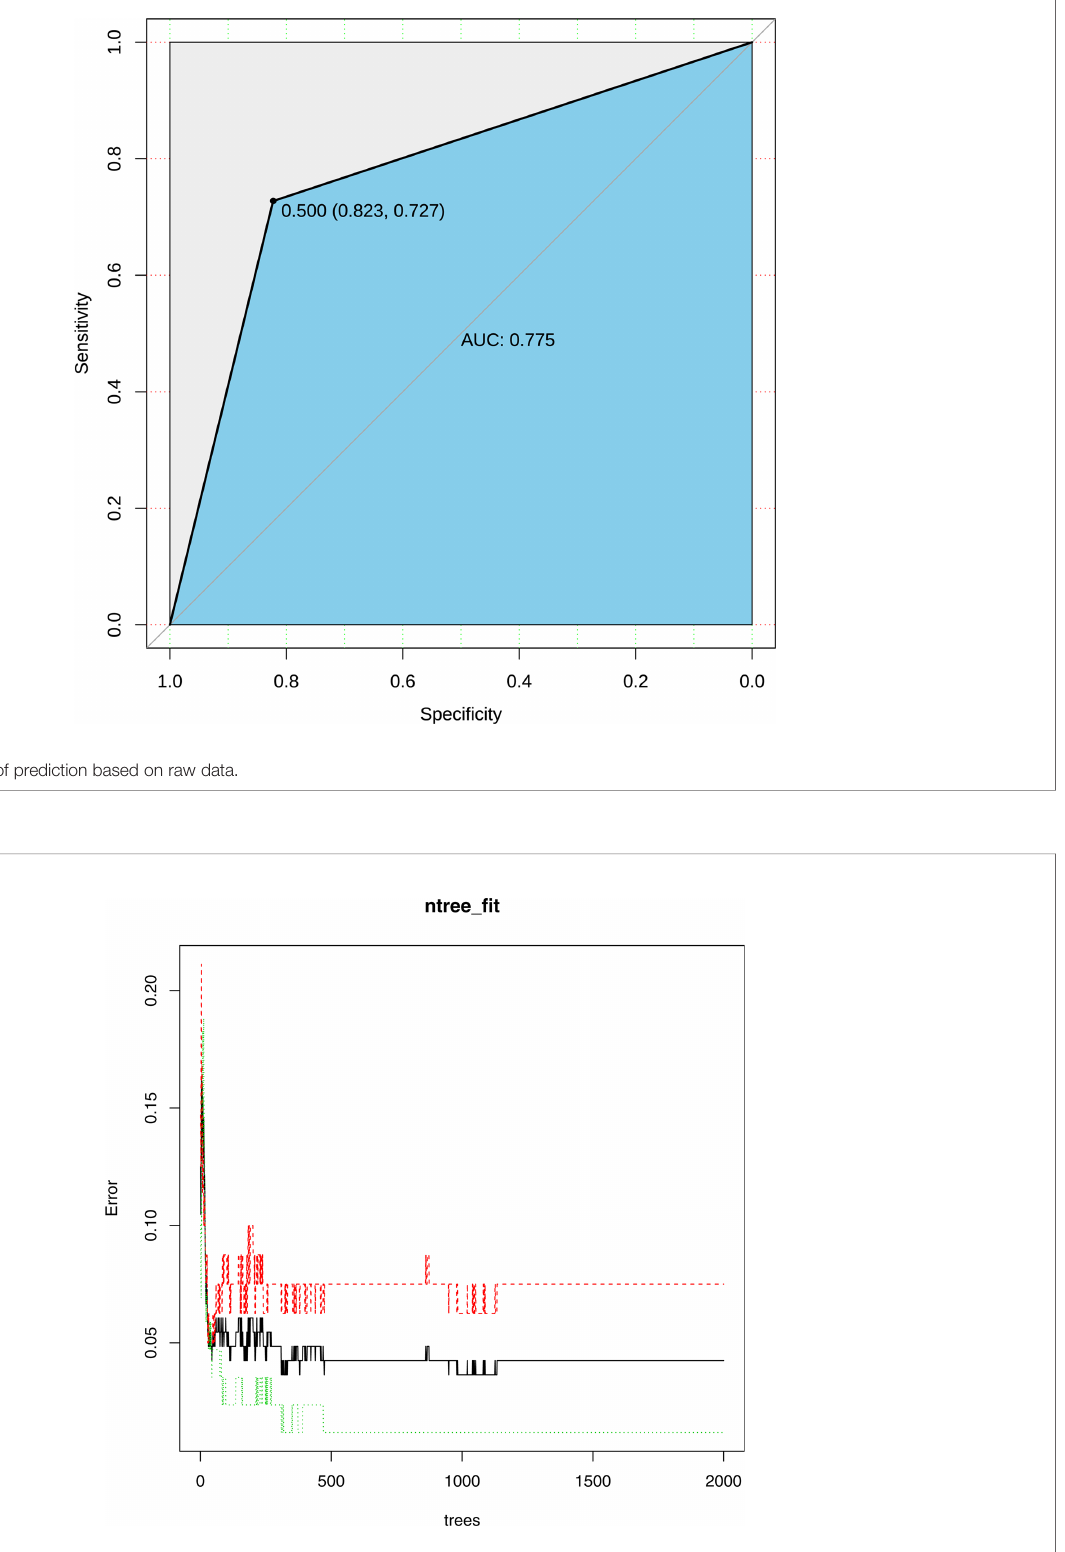
FIGURE 4 | The false positive rate of each tree in the random